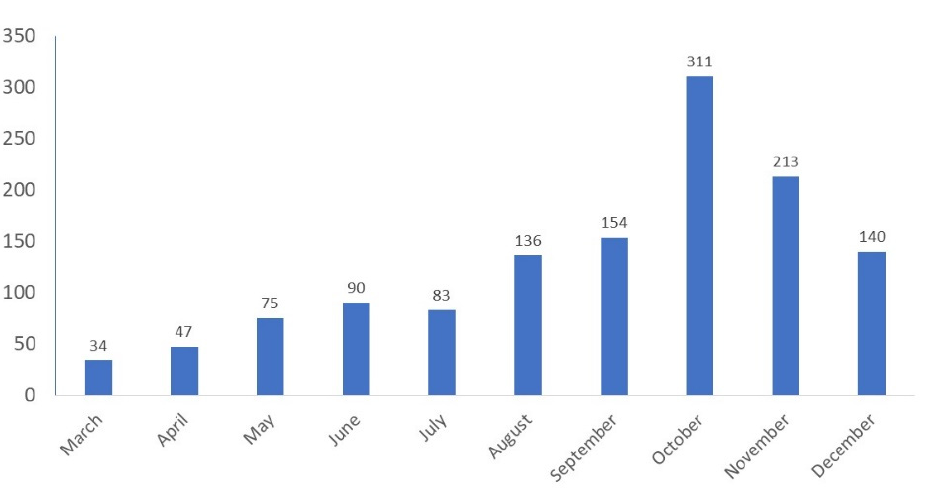
Figure 1. The number of COVID-19 cases in pediatric patients reported in the SARSTer-PED register throughout 2020. Table 1. Clinical presentation and epidemiological characteristics of COVID-19 in the study group and in different age groups.